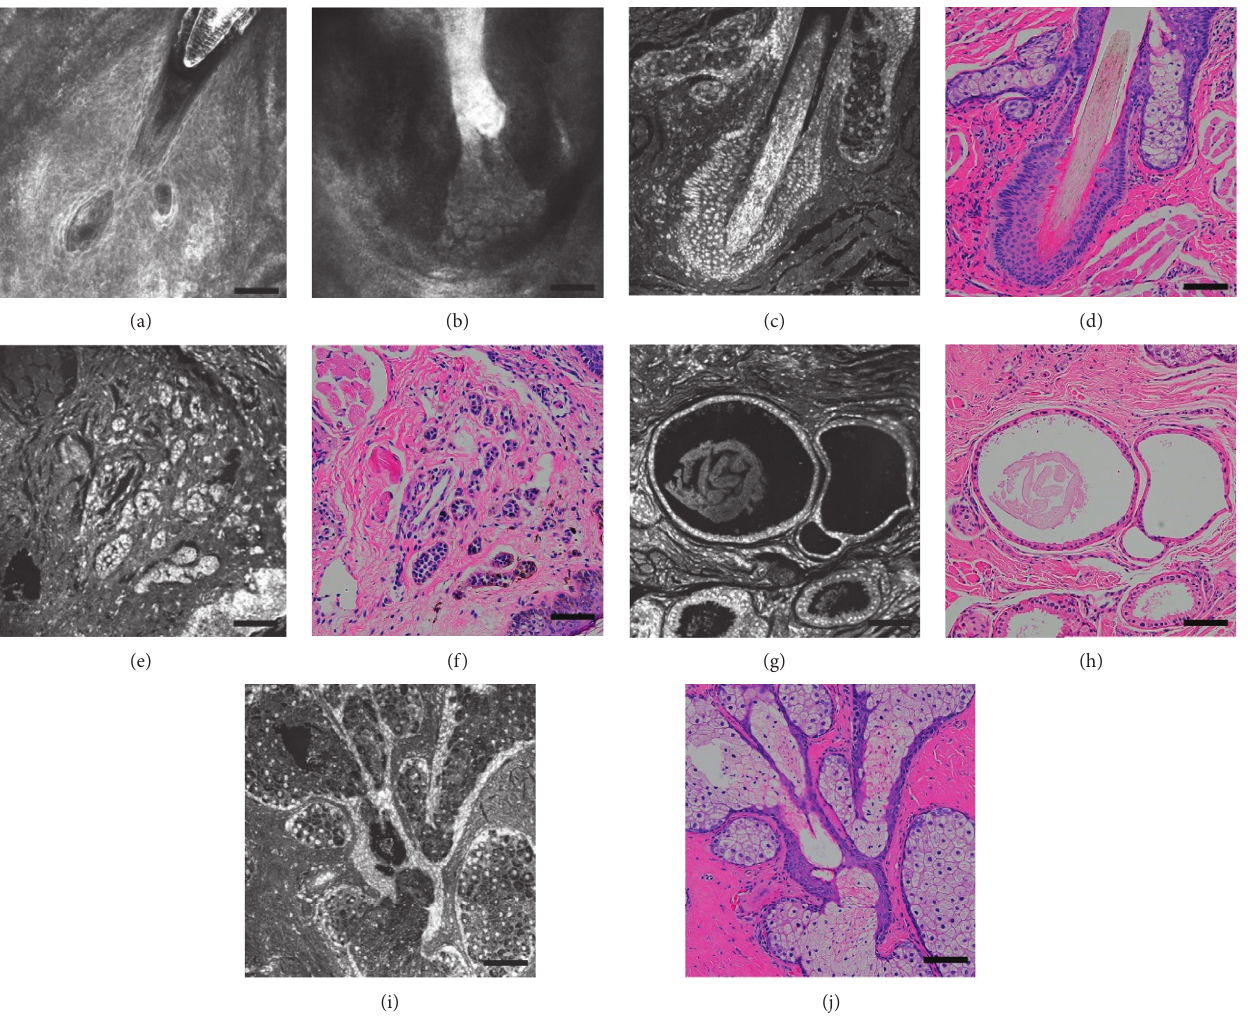
Figure 3: Appendages and subcutis. In vivo confocal microscopy mode can only observe superficial hair follicles (a) and parts of glands of Zeis (b) opens into the hair follicle. The follicles, gland of Zeis ((c) ex vivo confocal microscopy mode; (d) H&E stained section), and eccrine gland ((e) ex vivo confocal microscopy mode; (f) H&E stained section) can be observed on the superficial layer of the skin, the gland of